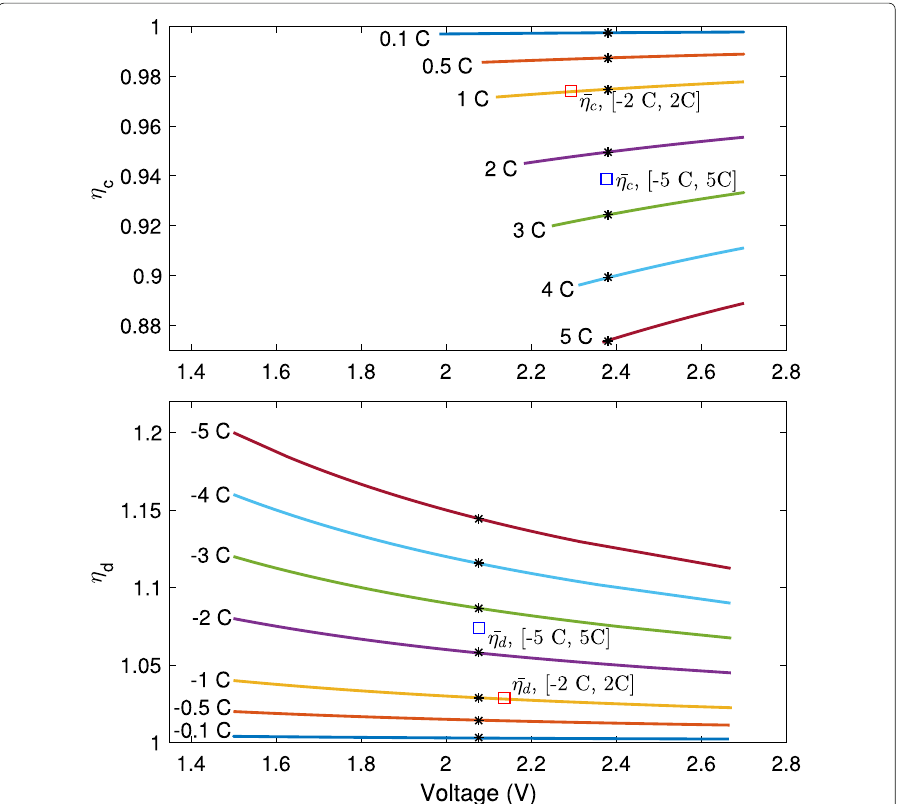
Fig. 4 The charging and discharging efficiencies of an LTO cell with R ic = R id = 0.002 m (cid:4) . Each solid line represents the efficiency calculated using Eqs. 7 or 8 at the labeled charging/discharging C-rate. Each asterisk represents the approximation where V = V nom , c for charging and V nom , d for discharging. The constant approximations ¯ η c and ¯ η d are shown for two labeled operating